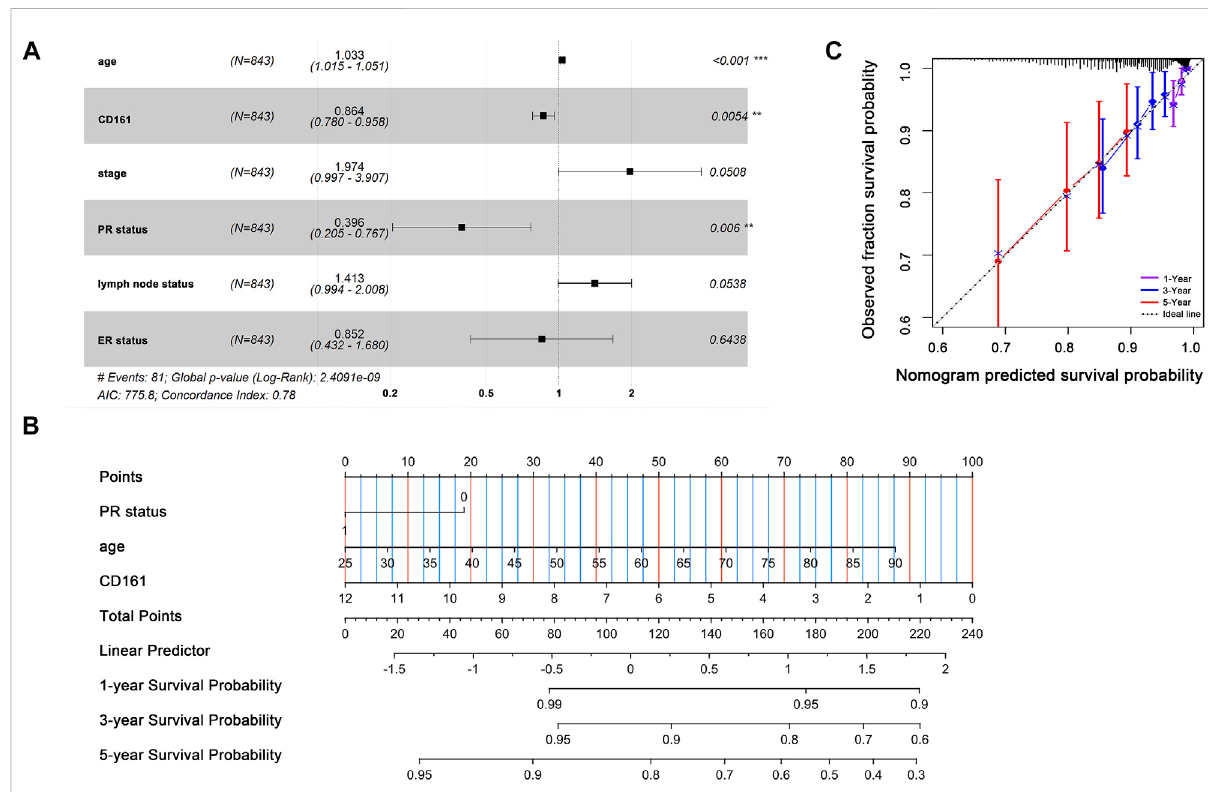
FIGURE 3 Prognostic value of CD161 expression in BC patients. (A) Multivariate Cox analyses on variables for the prediction of overall survival of BC patients. The effect ofPRstatus, ageand CD161 expression onsurvivalwas statistically signi fi cant. The results weredemonstrated asaforest plot. (B) A constructed nomogram for prognostic prediction of BC patients. For PR status, 0 represented PR-negative status and 1 represented PR-positive status. The importance of each variable was ranked according to the standard deviation along nomogram scales. To use the nomogram, the speci fi cpoints ofindividual patients werelocated oneach variable axis. Lines and dotsweredrawn upwardto determine thepoints received byeach variable; the sum of these points was located on the Total Points axis to determine the probability of 1-year, 3-year and 5-year OS. (C) Calibration curves of the nomogram. The dotted line indicated the ideal reference line where predicted probabilities would match the observed survival rates. The dots were calculated by bootstrapping (resample: 1000) and represented the performance of the nomogram. The closer the solid lines were to the dotted line, the more accurately the model predicted survival. The purple solid line, blue solid line and red solid line represented the calibration curve of 1-year OS, 3-year OS and 5-year OS separately. OS, overall survival; BC, breast cancer; PR, progesterone receptor. * p < 0.05, ** p < 0.01, *** p <